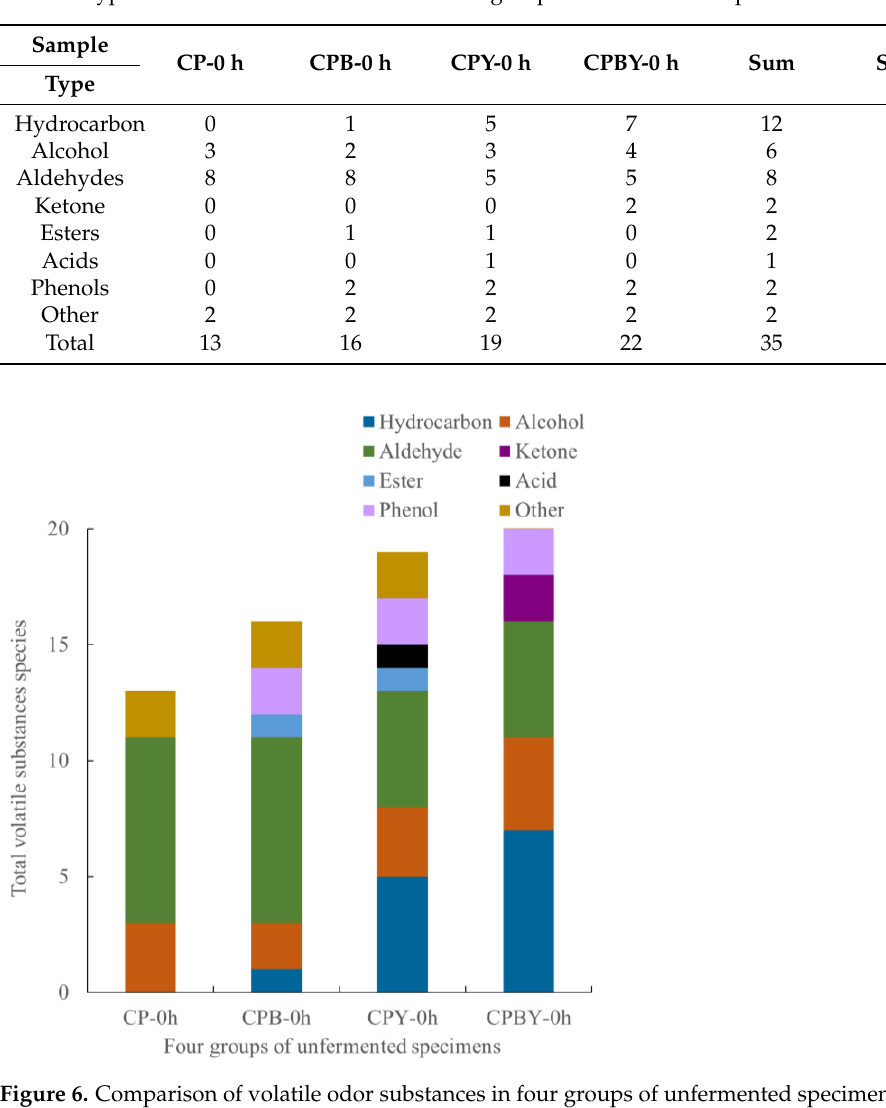
Table 4. Volatile odor substances in four groups of fermented specimens.